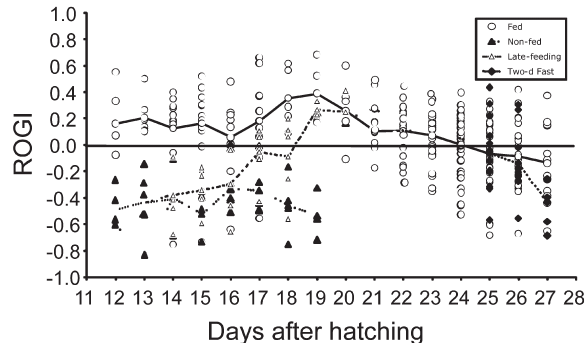
Fig . 6. – residuals plot (recent otolith growth index, rogi) for the four feeding